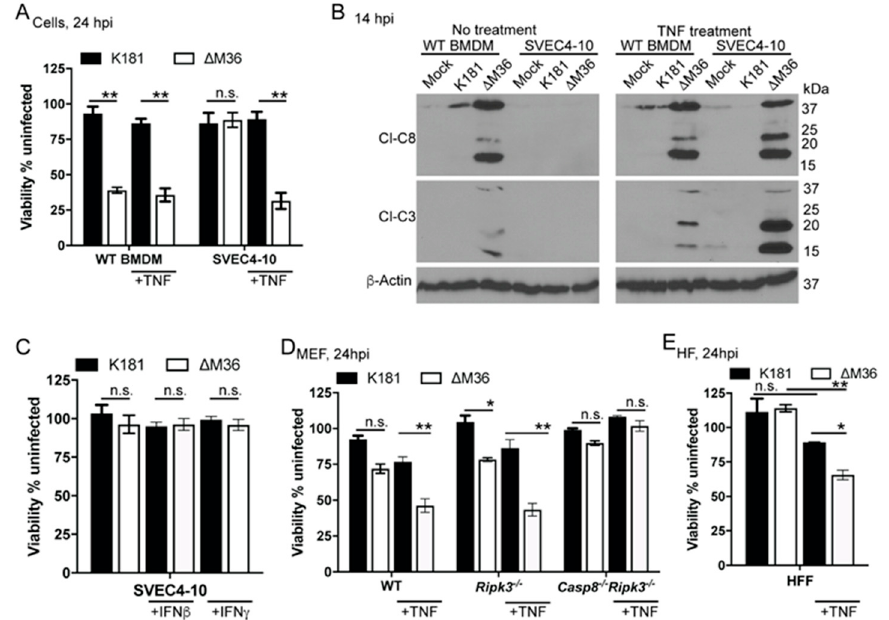
Figure 3. TNF drives ∆ M36-dependent apoptosis in endothelial cells and fibroblasts. ( A ). Relative viability of WT BMDM and SVEC4-10 cells infected with K181 or ∆ M36 (MOI = 10) for 24 h in the absence or presence of murine TNF (25 ng/mL). TNF was added to medium 1 hpi. Graph reflects data pooled from three independent experiments, each containing 3 replicates. ( B ) . IB showing the appearance of Cl-C8 and Cl-C3 with loading control β -actin 14 hpi in WT or SVEC4-10 cells under indicated conditions. Data are representative of 2 independent experiments. ( C – E ) . Relative viability of SVEC4-10 treated with no cytokine, murine IFN β or IFN γ (100 ng/mL each), ( C ), MEFs of indicated genotypes treated with murine TNF (25 ng/mL) ( D ) or HF treated with human TNF (100 ng/mL) ( E ) and infected with K181 or ∆ M36 (MOI = 10) at 24 hpi. All cytokines were added to the medium at 1 hpi with virus. C-E reflect data pooled from two independent experiments, each containing 3 replicates. Lines above bars indicate the two groups compared for significance values using paired, parametric Student’s t -test where * is < 0.05, ** is < 0.01, and n.s. represents nonsignificant.